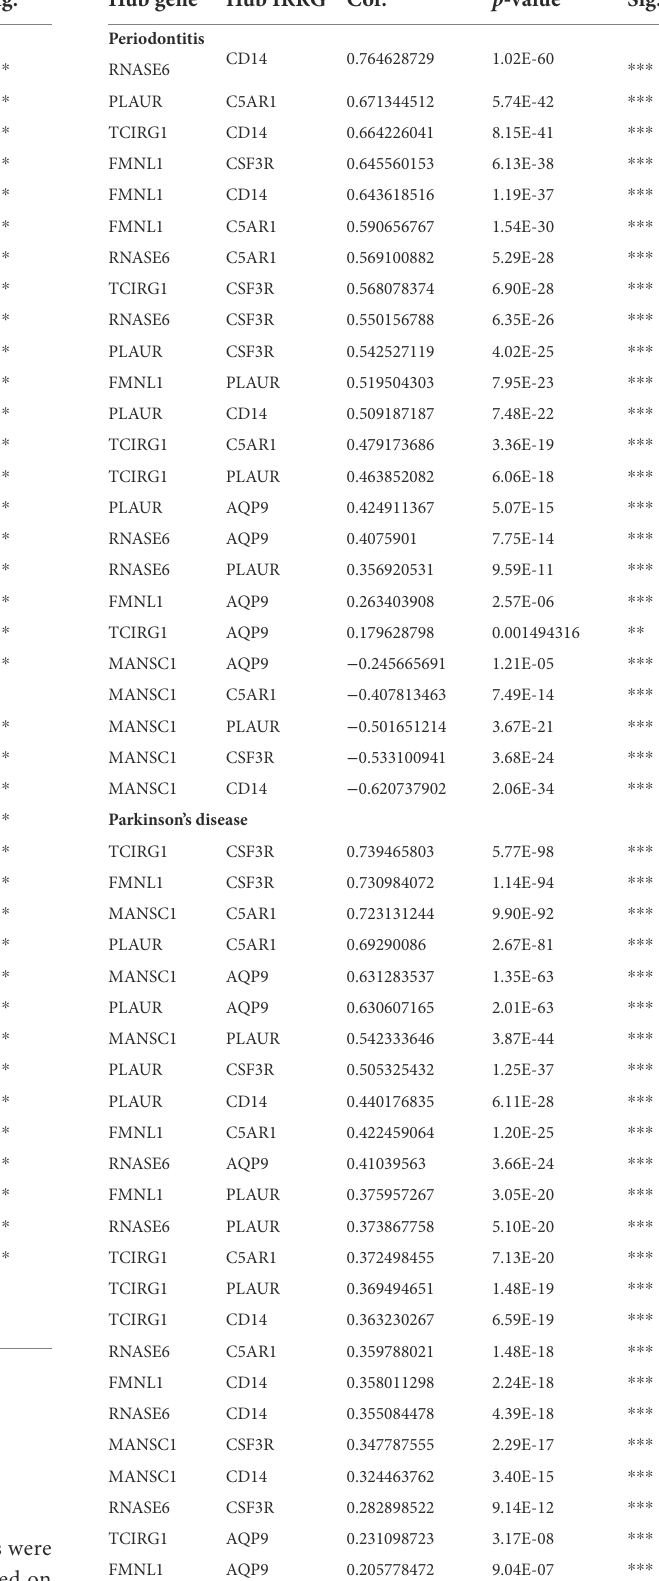
TABLE 5 The correlation among hub crosstalk genes in periodontitis and Parkinson’s disease, respectively. Hub gene Hub gene Cor. p -value Sig.